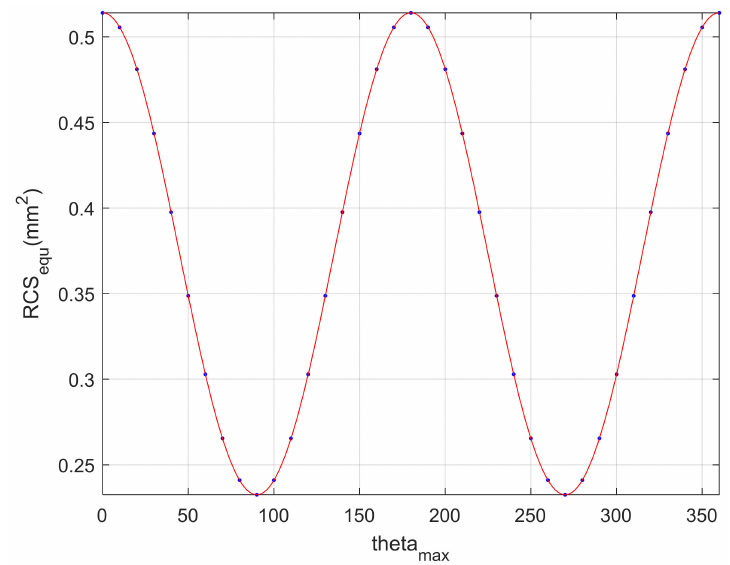
Figure 10. The insect-equivalent RCS